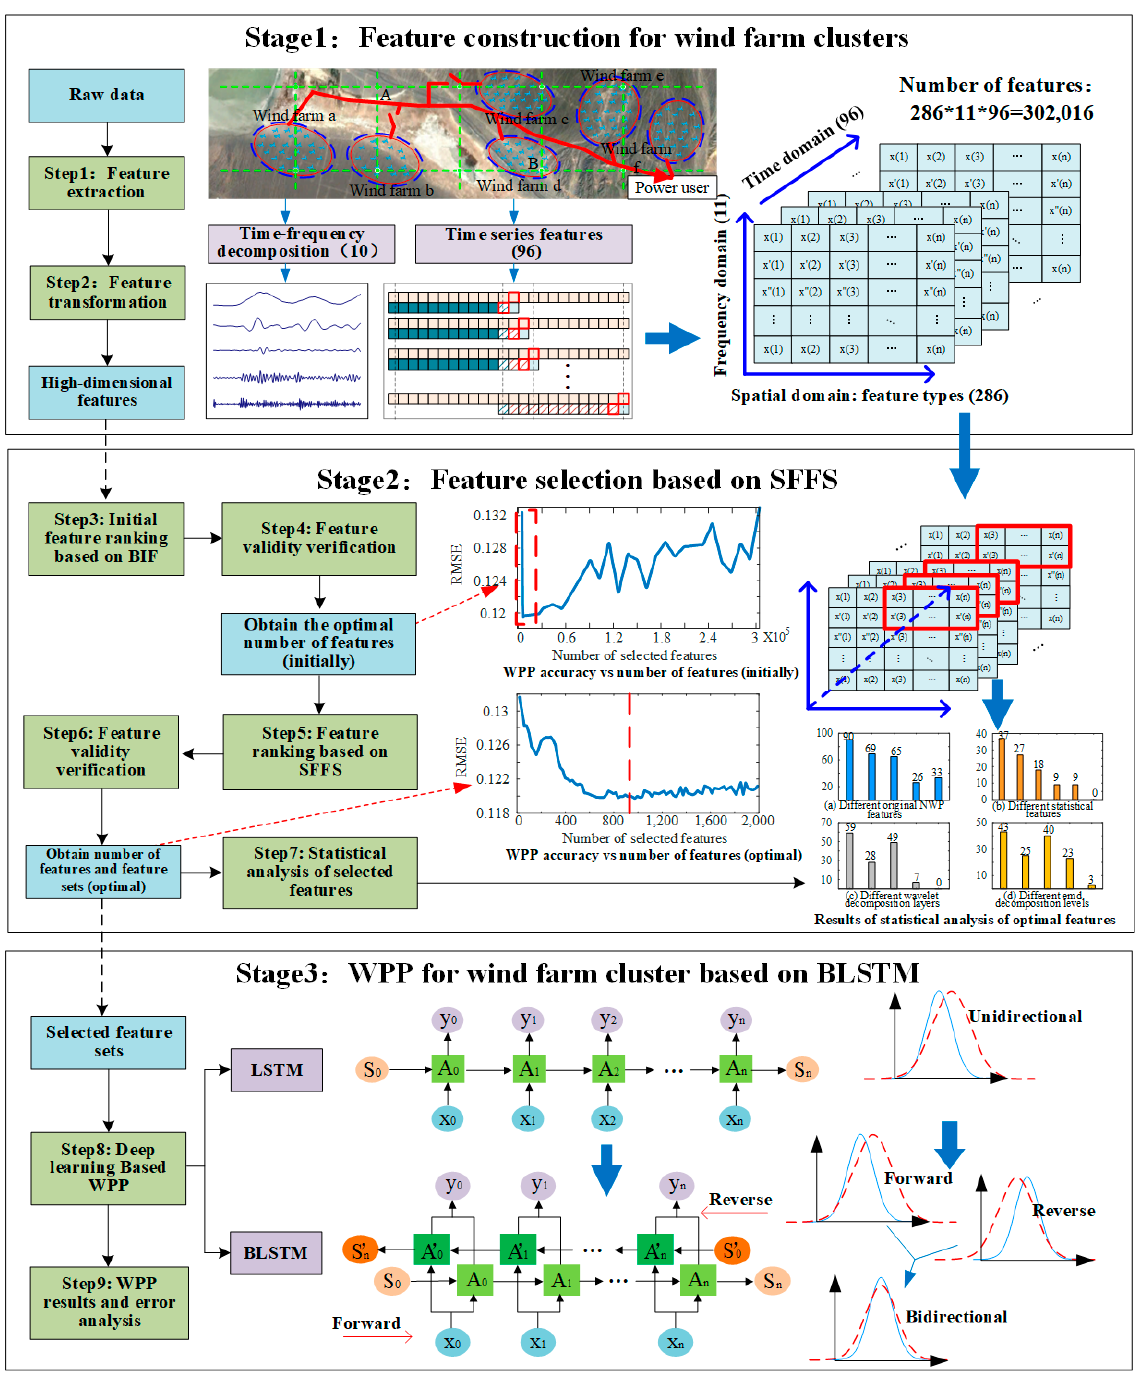
Figure 1. Overall flowchart of sequential floating forward selection-bidirectional long short-term memory (SFFS-BLSTM).